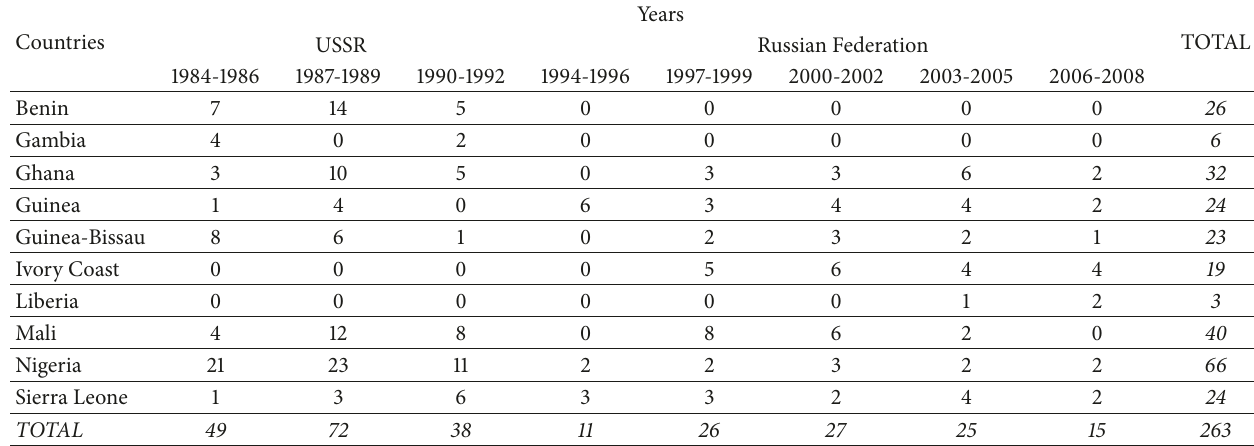
Table 1: Origin of imported P. vivax cases in the USSR and Russian Federation from 1984-2008.